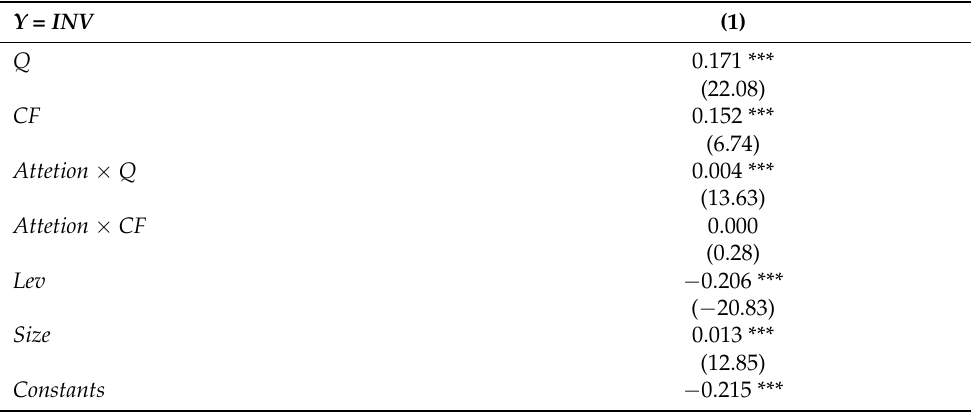
Table 8. Test results of capital allocation